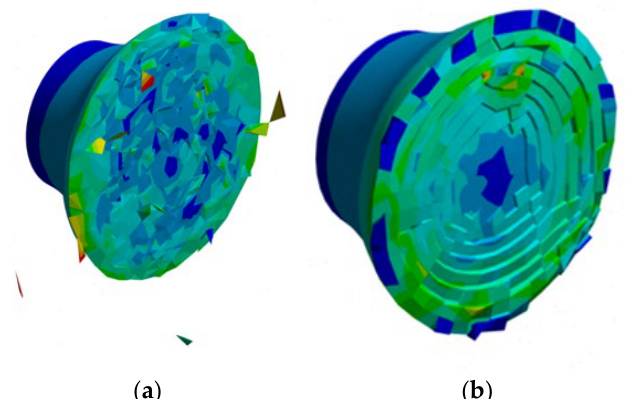
Figure 12. The remaining fragmentation of the modeling result ( a ) AMMO 1; ( b ) AMMO